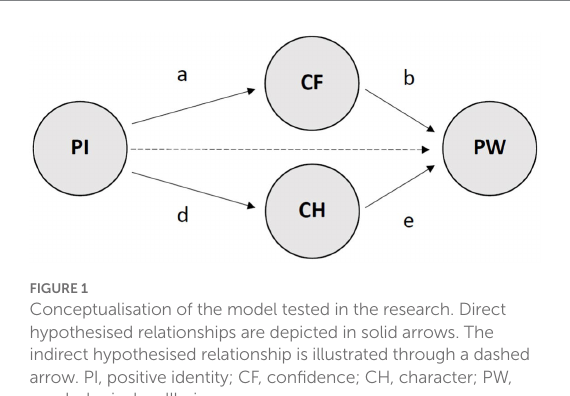
FIGURE 1 Conceptualisation of the model tested in the research. Direct hypothesised relationships are depicted in solid arrows. The indirect hypothesised relationship is illustrated through a dashed arrow. PI, positive identity; CF, confidence; CH, character; PW, psychological wellbeing.